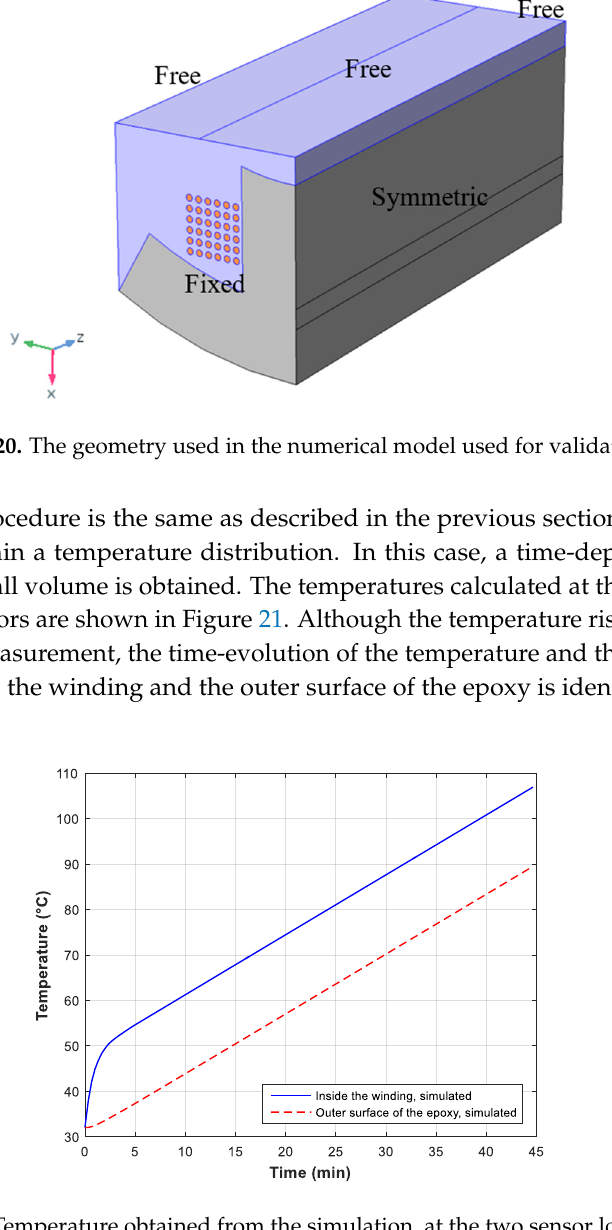
Figure 21. Temperature obtained from the simulation, at the two sensor locations.